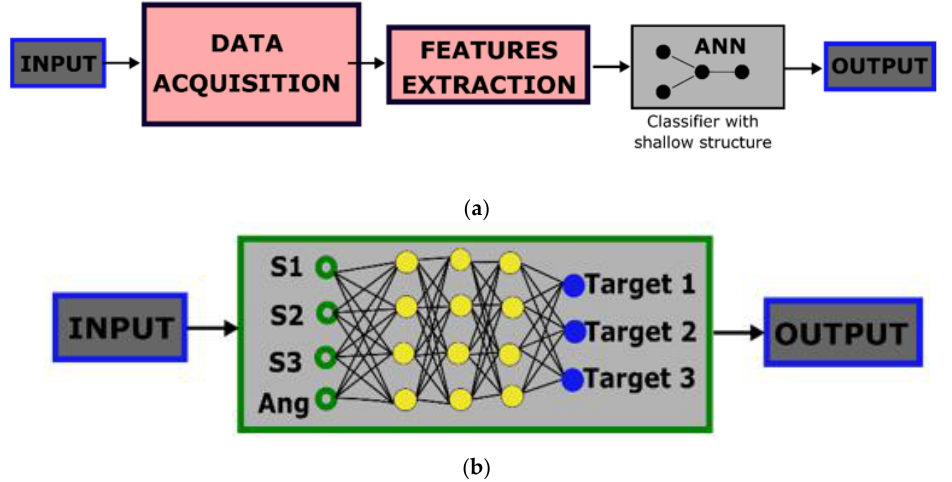
Figure 3. Schematic diagrams: ( a ) general processing data system extraction + selection, ( b ) neural network features learning + classifier .